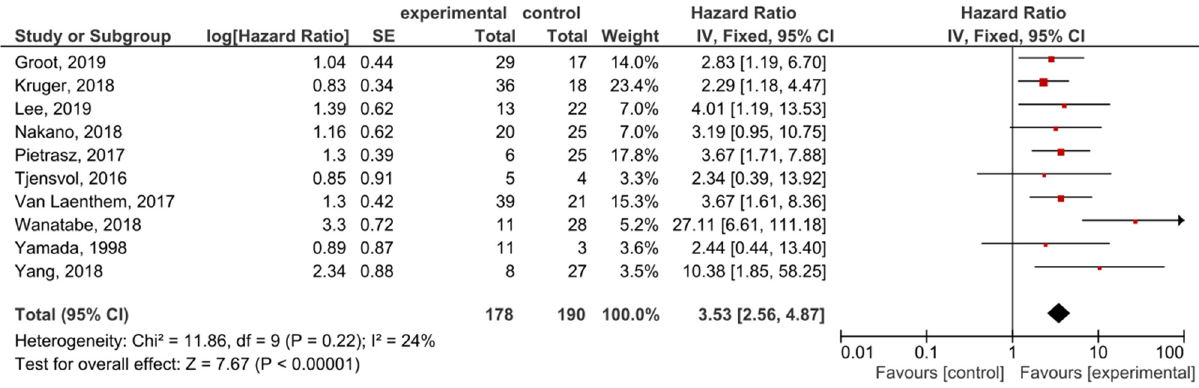
Figure 5. Forest plot presenting the relationship between the presence of KRAS mutations after treatment in PDAC patients and OS.